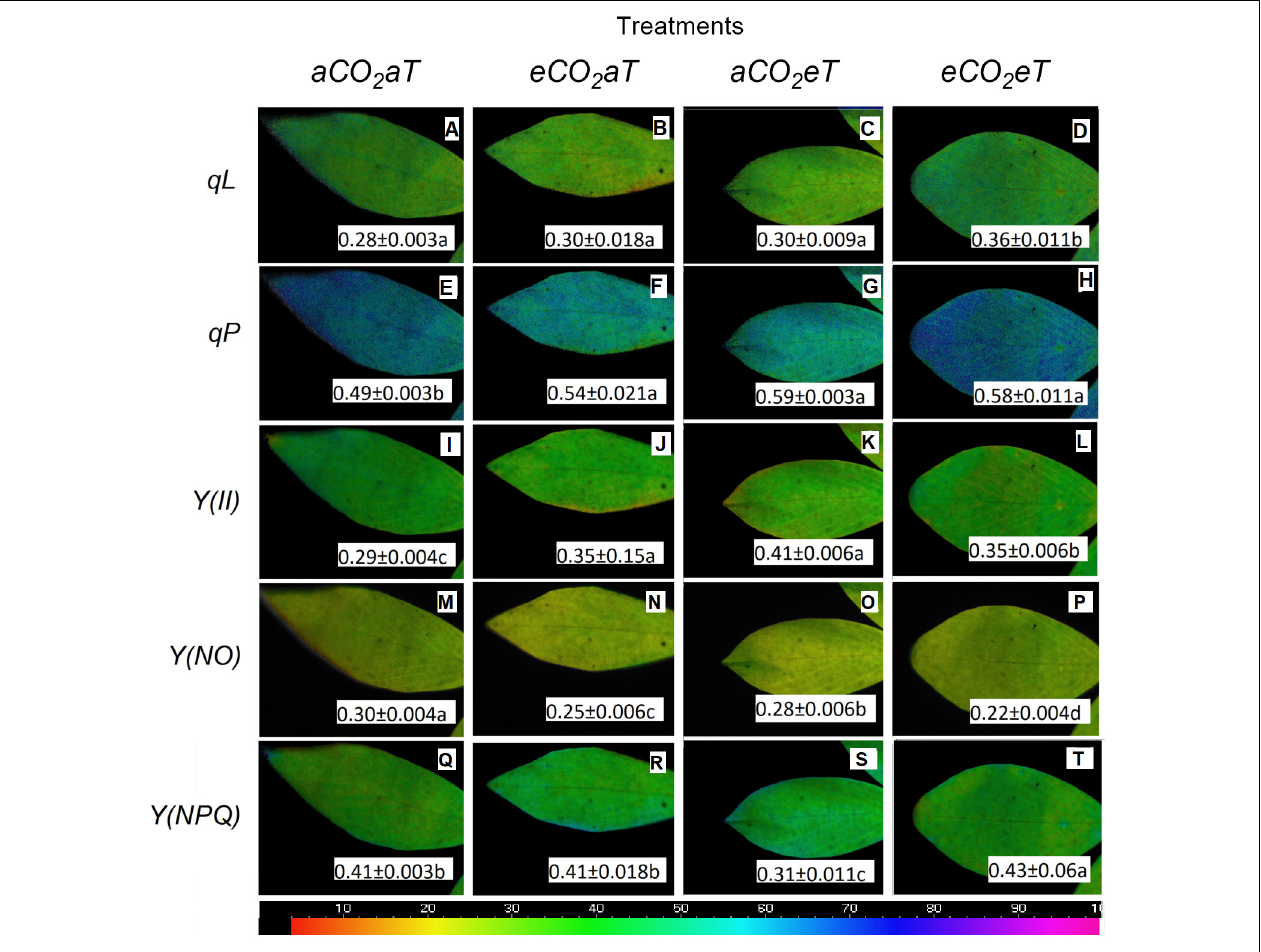
FIGURE 8 | Images of chlorophyll fluorescence parameters made in leaves of S. capitata exposed to different levels of atmospheric [CO 2 ] and temperature at maximum PPFD (784 µ mol photons m − 2 s − 1 ). (A–D) Coefficient of photochemical quenching (lake model) (qL ). (E–H) Coefficient of photochemical quenching (puddle model) ( qP ). (I–L) Effective PSII quantum yield Y(II). (M–P) Quantum yield of non-regulated energy dissipation Y(NO). (Q–T) Quantum yield of regulated energy dissipation Y(NPQ). Measurement was performed at 66th day of experiment. [CO 2 ] levels: ambient ( aCO 2 ) and elevated ( eCO 2 , 600 µ mol mol − 1 ). Temperature levels: ambient ( aT ) and elevated ( eT , +2 ◦ C above ambient canopy temperature). Different letters in the same row indicate statistical differences between treatments determined by t -test. Relative values of each parameter in the images have been mapped to a color palette ranging from 0 to 1 and displayed using an identical false color scale (bar is at the bottom of